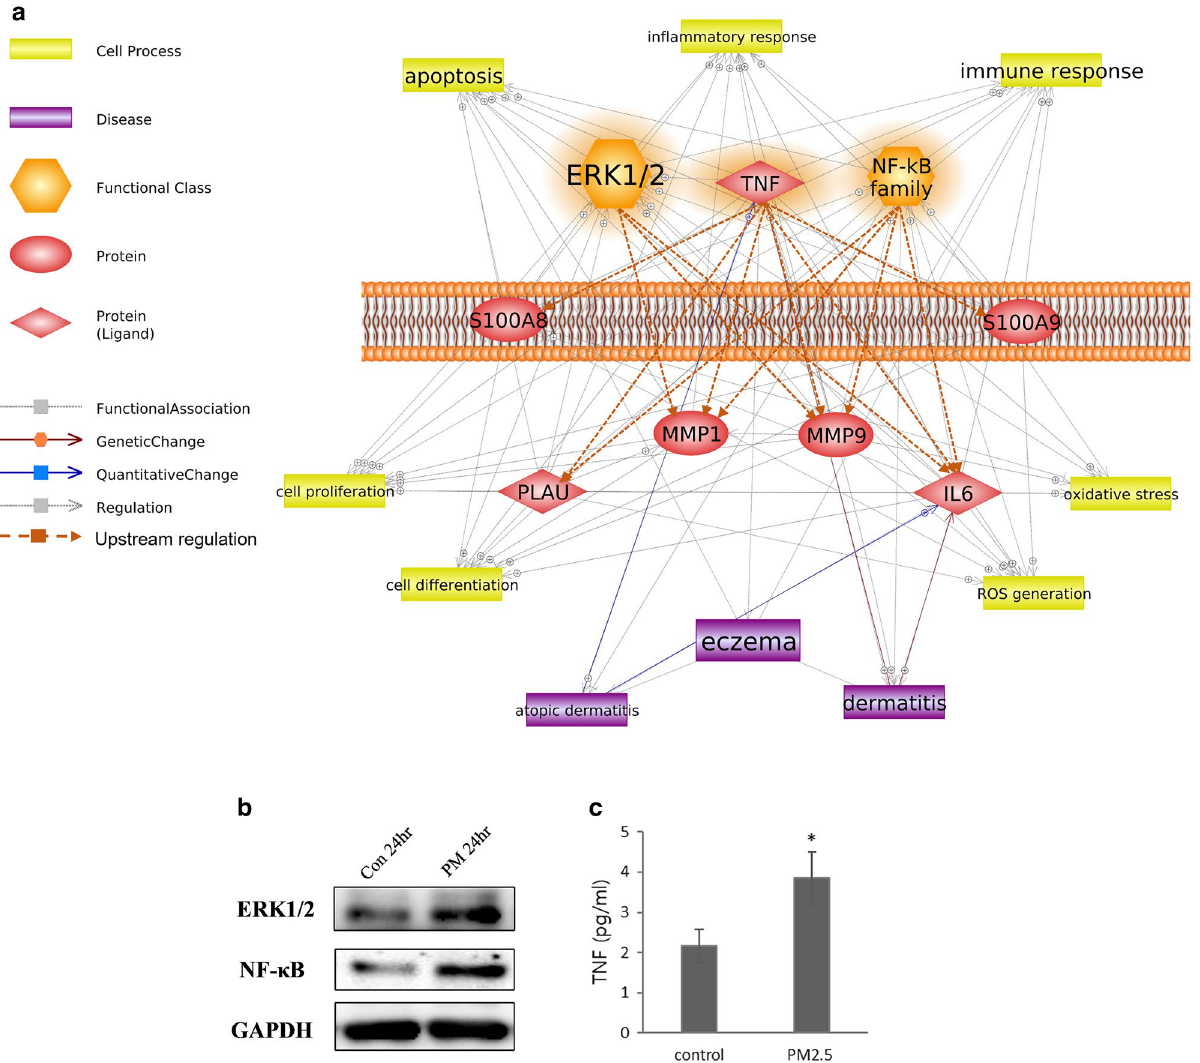
Figure 5. Integrative identification through simplified signaling network of upstream regulators and hub genes altered in skin under PM exposure. ( a ) PM-induced biological pathway consisting of hub genes, upstream regulators, cell processes, and disease. Genes highlighted in orange indicate upstream regulators. ( b ) Validation at the protein level was performed through Western blot. The expressions of NF-κB and ERK1/2 changed, as predicted. c ELISA-based validation of upstream regulator proteins. TNF expression changed significantly, as predicted. * indicates 0.001 < p < 0.05.